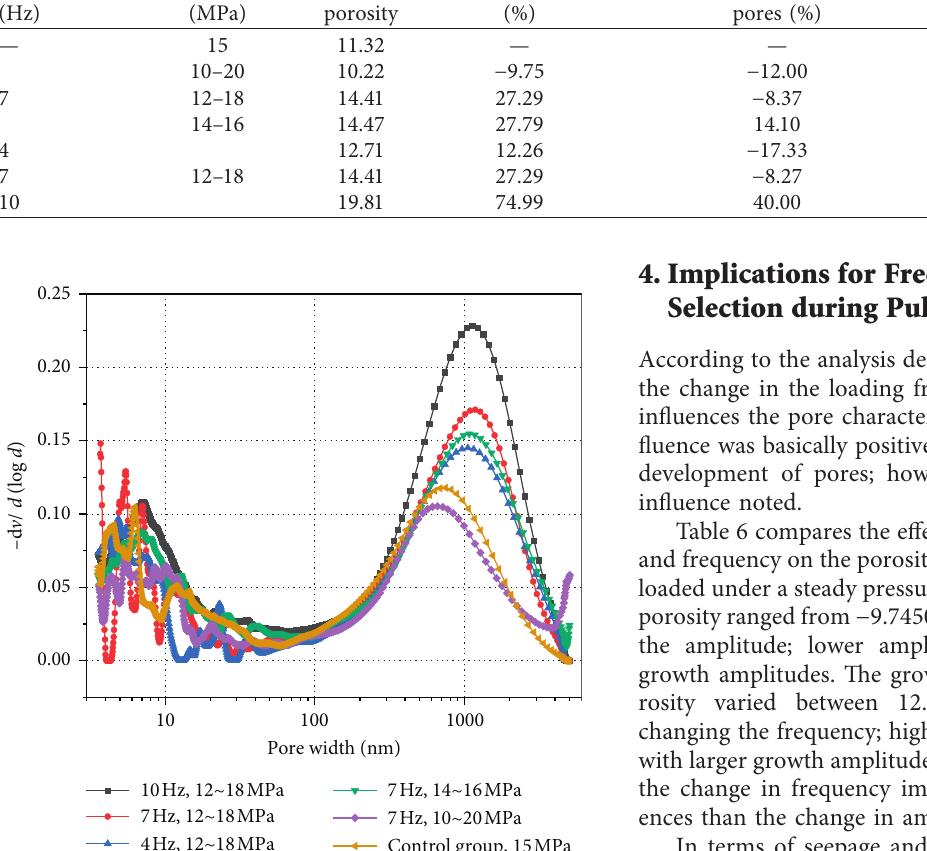
Table 6: Comparison of the growth amplitudes of the porosity under different loading conditions. Frequency